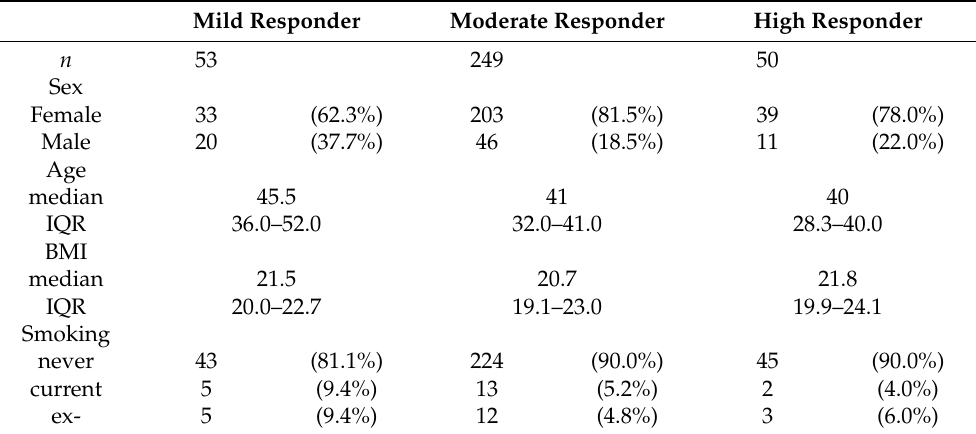
Figure 5. Third dose of BNT162b2 vaccination augments anti-RBD IgG responses of mild responders at the peak of the second dose of BNT162b2 vaccination. ( A ) Cohort participants are divided into three groups based on anti-RBD IgG titers (SUM) at 2D-1M, namely, mild responder: <mean − 1 SD (expressed in blue, moderate responder: mean ± 1 SD (expressed in black) and high responder: mean + 1 SD ≤ (expressed in green). ( B – D ) Anti-RBD IgG titers at 1 M after the third dose of BNT162b2 vaccination (3D-1M) of mild ( B ), moderate ( C ) and high responders ( D ) determined at 2D-1M were compared with the titer of 2D-1M in these three groups. Table 2. Characteristics of three groups based on anti-RBD IgG responses at 2D-1M (mild, moderate high responders).